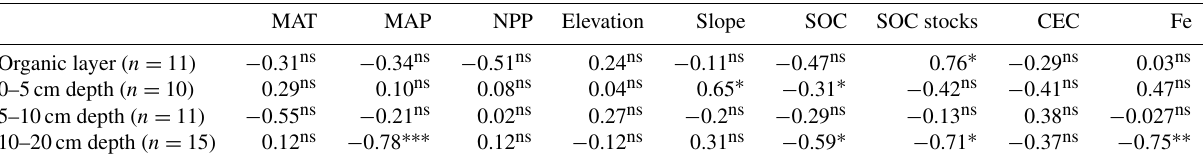
Table 5. Spearman correlation of (cid:49) 14 C vs. climatic variables. Significant correlations are found between (cid:49) 14 C against MAP and SOC at 10–20cm. For p values p< 0 . 05, p< 0 . 005 and p< 0 . 0005, values correlations are indicated with ∗ , ∗∗ and ∗∗∗ , p> 0 . 05 is indicated with superscript “ns”. Cation Exchange Capacity (CEC) in mmolkg − 1 was calculated as defined by Blume et al. (2002). Iron (Fe) content